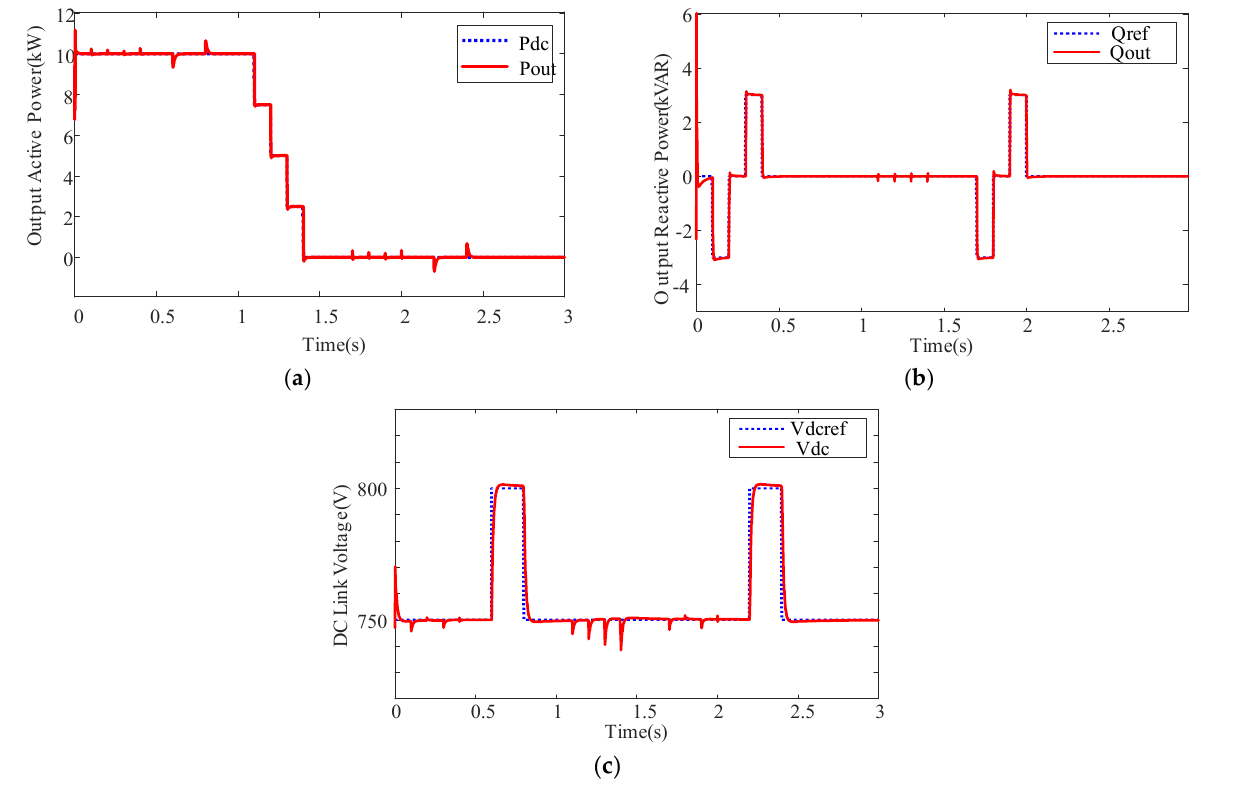
Figure 6. Dynamic response of the overall system consists of ( a ) P out ; ( b ) Q out ; and ( c ) V dc with their reference values when the observer is used in the control loop of GFL inverter.